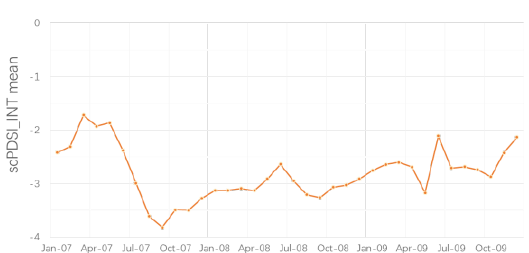
Figure 3. Drought Intensity in Drought Area